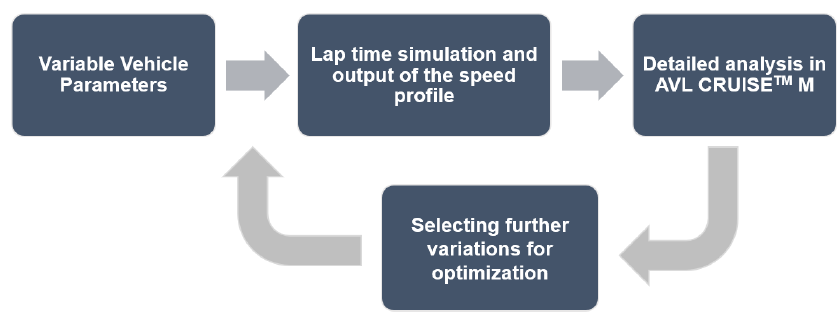
Figure 9. Optimization process using the lap time simulation and AVL CRUISE TM M